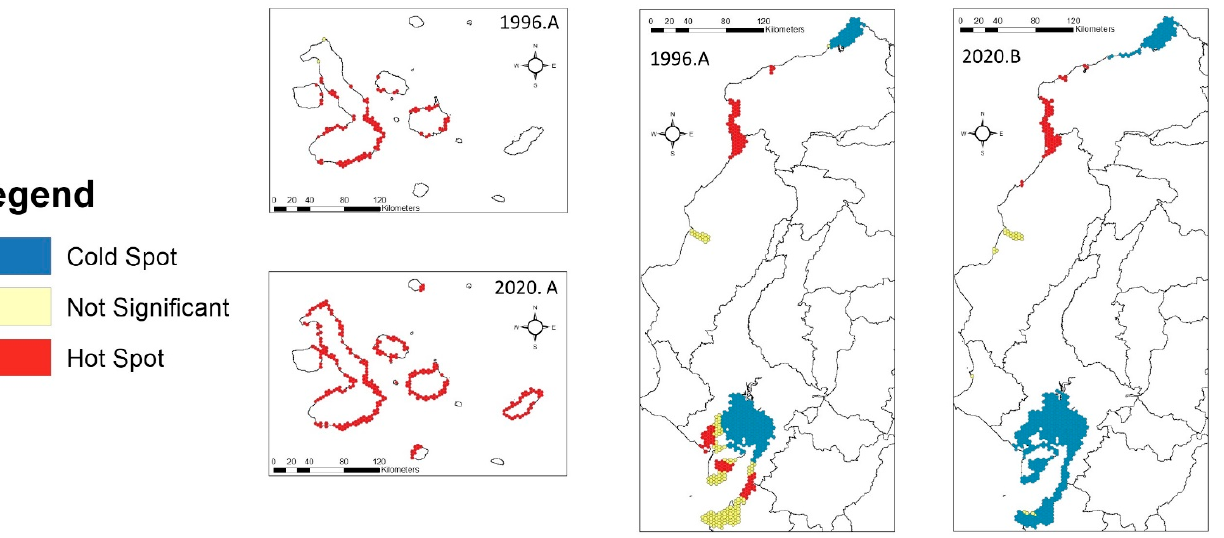
Figure 5. Comparison of the hot and cold spots of Ecuadorian mangrove forests by means of Getis– Ord Gi* analysis in the years 1996 and 2020. Zone ( A ) corresponds to the Galapagos and zone ( B ) to the continental coast.